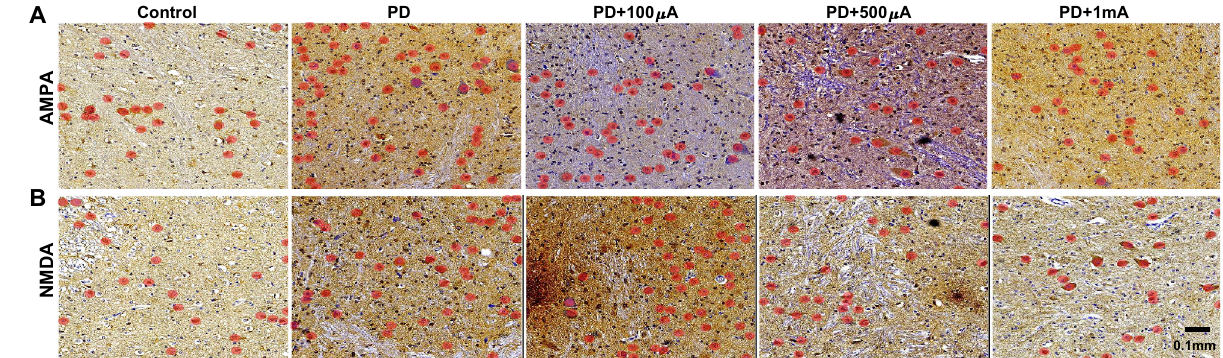
Figure 5. Immunohistochemistry examples with glutamate receptors in vestibular nucleus (VN) in control, PD, PD with 100 μA, PD with 500 μA, PD with 1 mA. The targeted receptors are AMPA ( A ) and NMDA ( B ), and the number of the stained receptors indicated the effect by GVS. The given strength of GVS was calculated for electrical charge by Eq. 2. A AMPA * : 0.01 < p < 0.05 *** : p < 0.0001